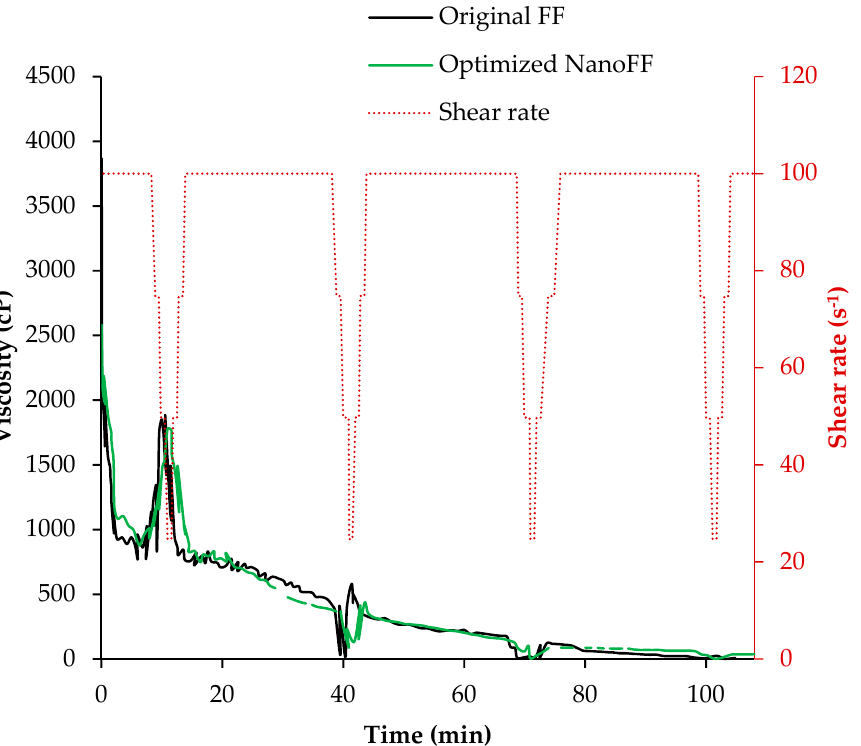
Figure 10. Rheological behavior of the original FF and optimized NanoFF under pressure and temperature of 87.7 °C and 5500 psig.